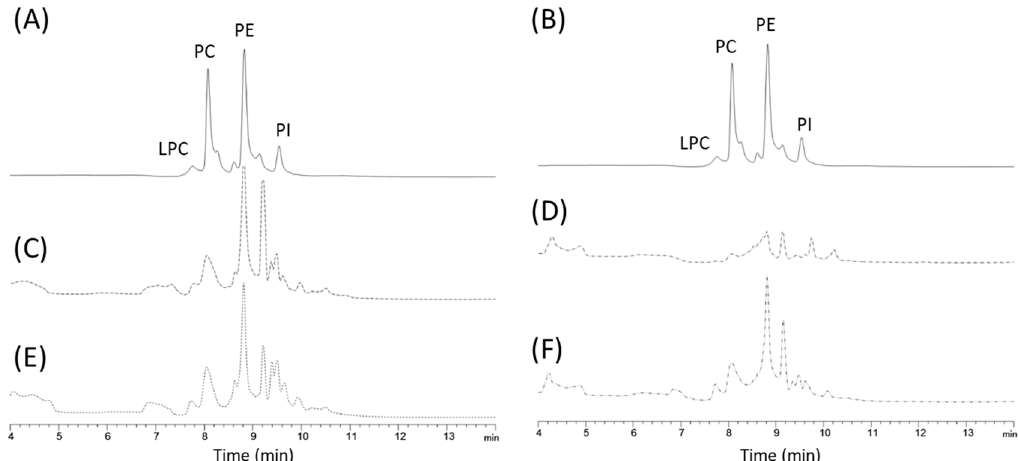
Figure 4. Overlaid HPLC-RP-UV chromatograms for the methanol/ACN extract of DEN/TAA-treated mouse livers at 7 weeks, receiving or not receiving SETIs. ( A , B ) Chromatographic signals for the standard mixture composed of Lysophosphatydilcholine (LPC), Phosphatidylinositol (PI), Phosphatidylcholine (PC), and Phosphatidylethanolamine (PE). ( C , D ): Chromatographic signals for hepatic extracts from mice fed a standard diet (STD) without receiving SETIs ( C ) or administered STEIs ( D ). ( E , F ) Chromatographic signals for the hepatic extracts from mice fed a high-fat diet (HFD) without receiving SETIs ( E ) or administered STEIs ( F ).